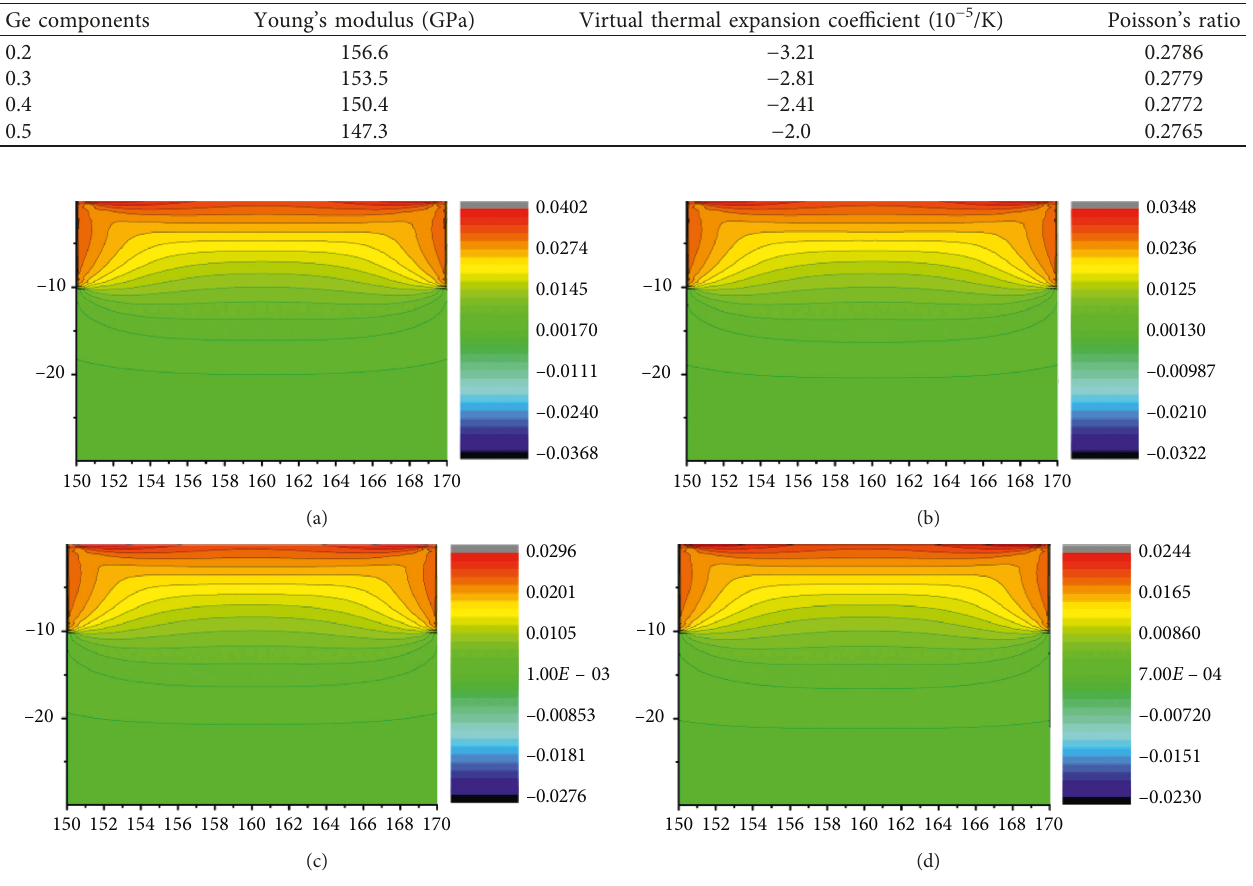
Table 2: Simulation parameters of the SiGe material under different Ge components.